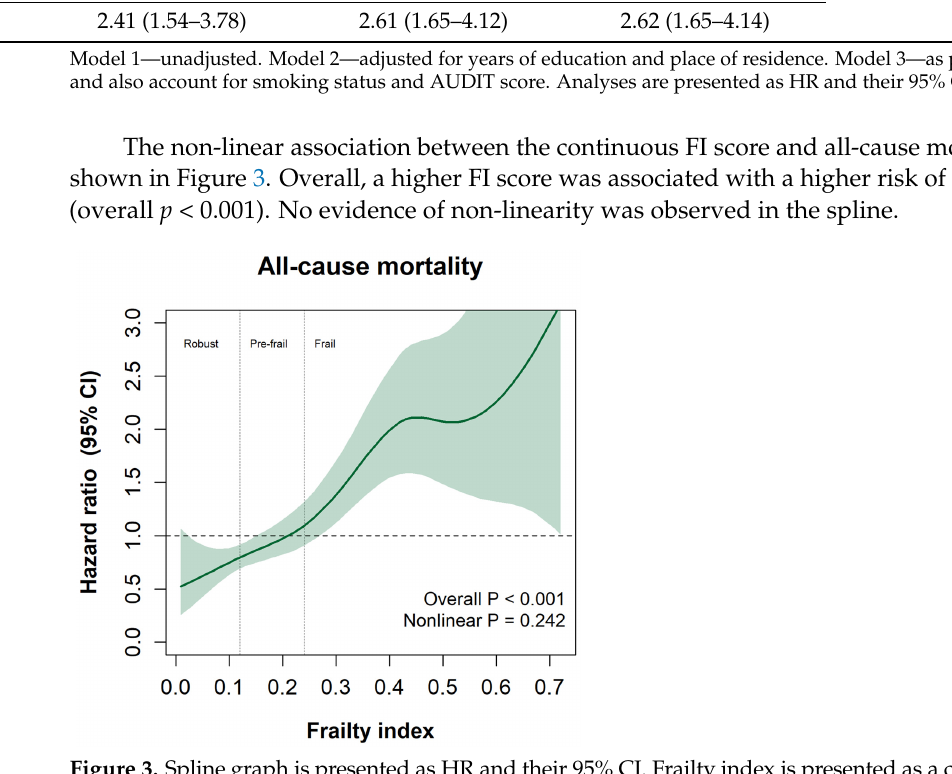
Figure 3. Spline graph is presented as HR and their 95% CI. Frailty index is presented as a continu- ous variable. All analyses were adjusted for age, sex, zone of residence, smoking status, and AUDIT